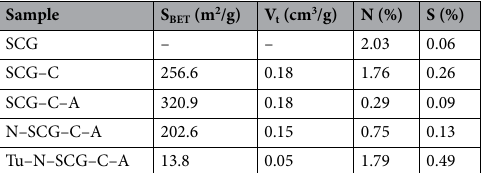
Table 1. Textural properties of spent coffee grounds and their derived biocarbons.